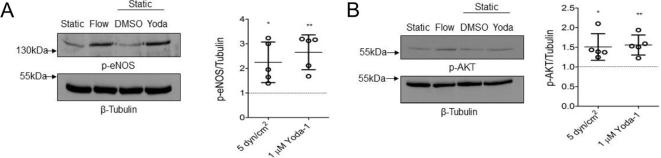
Endothelium treated with either Yoda-1 or shear stress both increase phosphorylation of AKT and eNOS. HUVEC were stimulated for 24 h with either 1 µM Yoda-1 or 5 dyn/cm2. Lysates were subjected to immunoblotting with anti-phospho eNOS (Ser 1177) (A) or anti-phospho Akt (Ser 473) (B). Anti-β Tubulin was used as a loading control. Representative blots and quantification by densitometric analysis are shown. β-Tubulin-corrected data are normalised against their appropriate static control lysate (dotted line). One-way ANOVA with Tukey’s post-test. *P < 0.01, **P < 0.001.